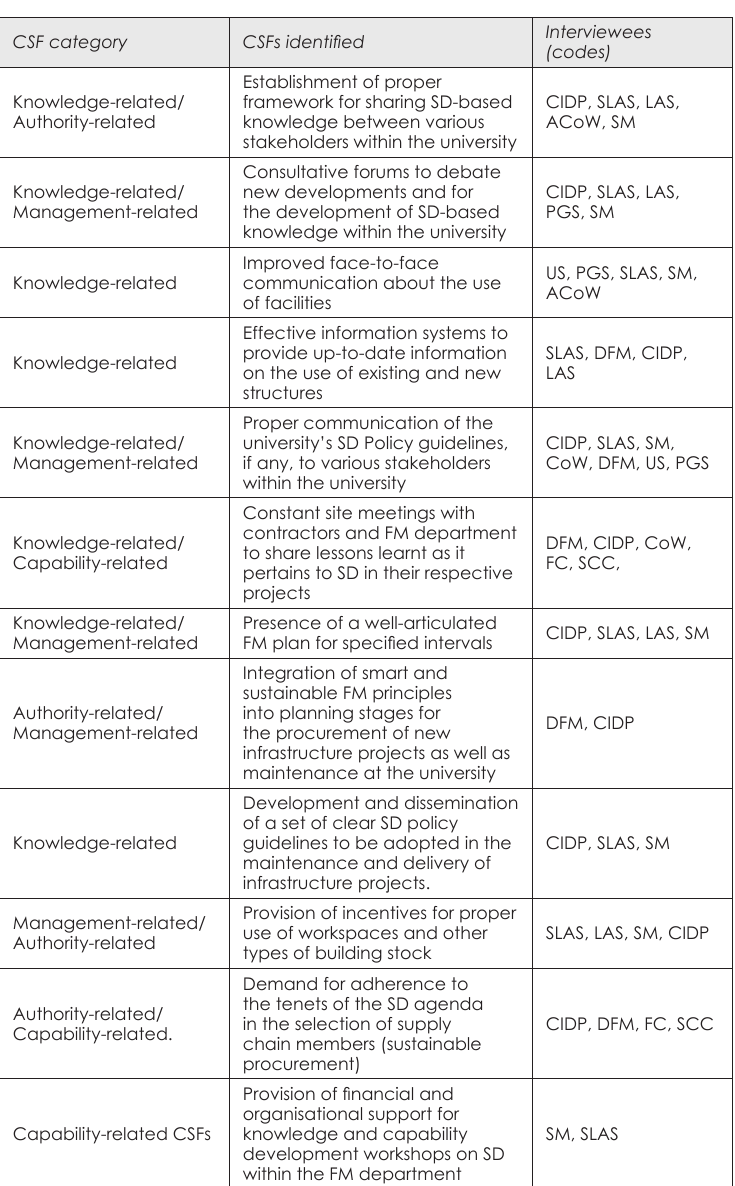
List of CSFs identified from the